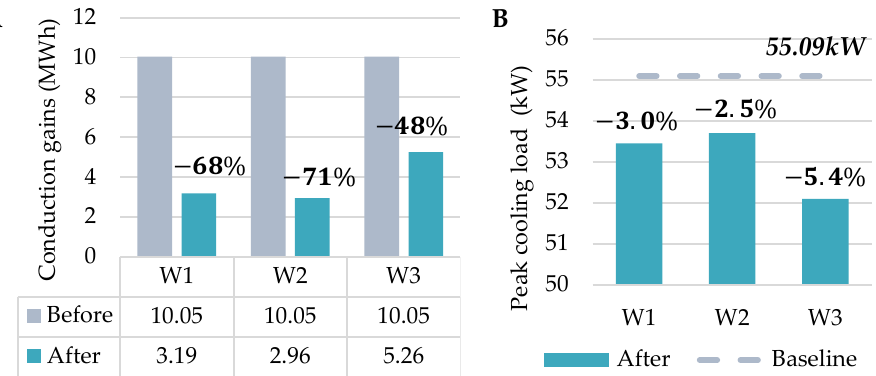
Figure 12. Energy performance breakdown of wall strategies, ( A ) Conduction gains, ( B ) Peak cooling load.